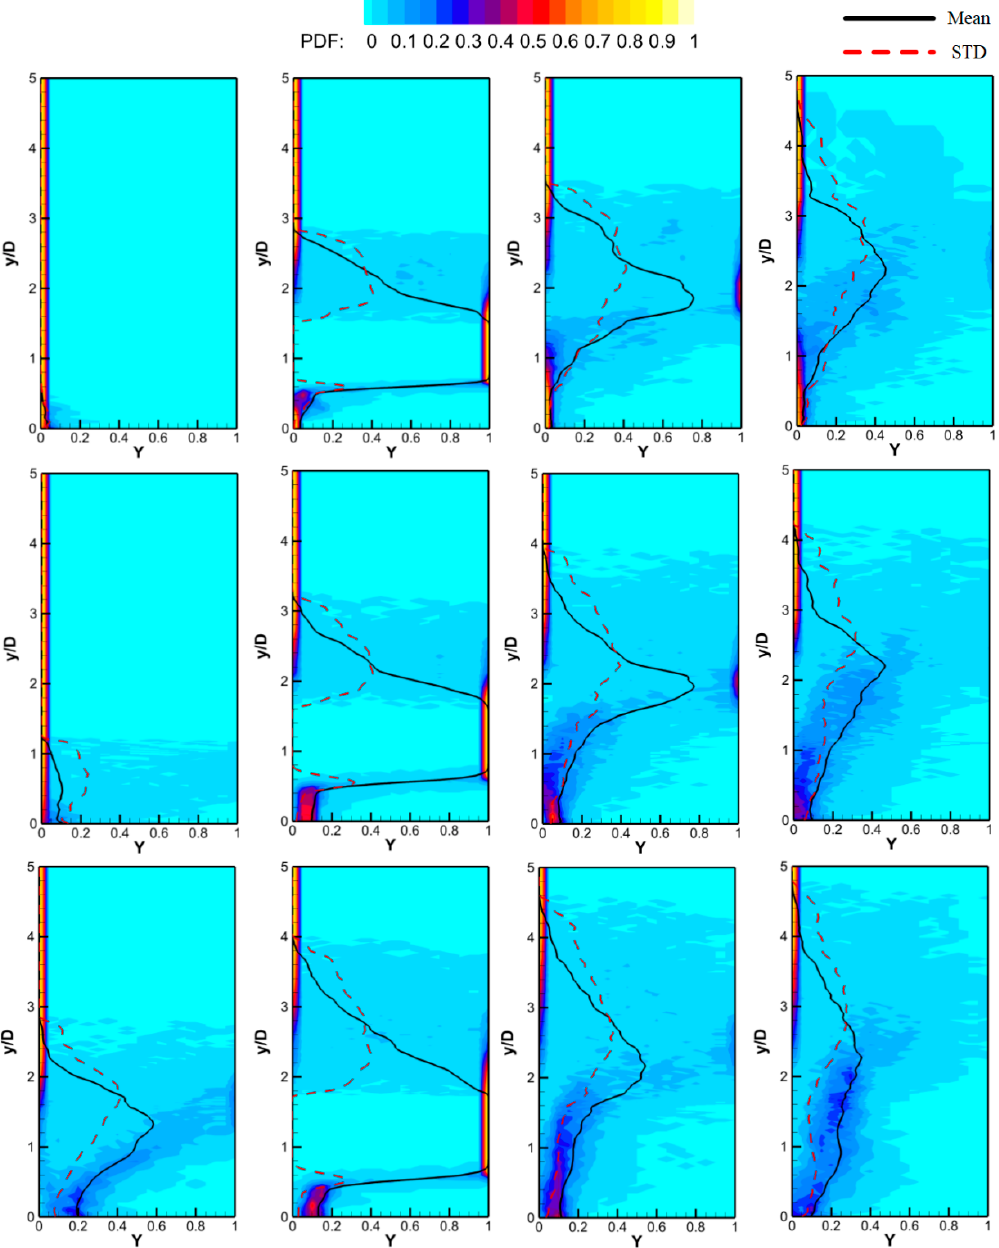
Figure 16. PDFs of the injectant mass fraction at x/D = − 1, 1, 3, and 5 in the center plane. Mean: time- averaged profile; STD: Standard deviation profile.